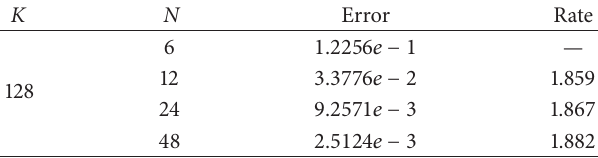
Table 2: Numerical results for Test